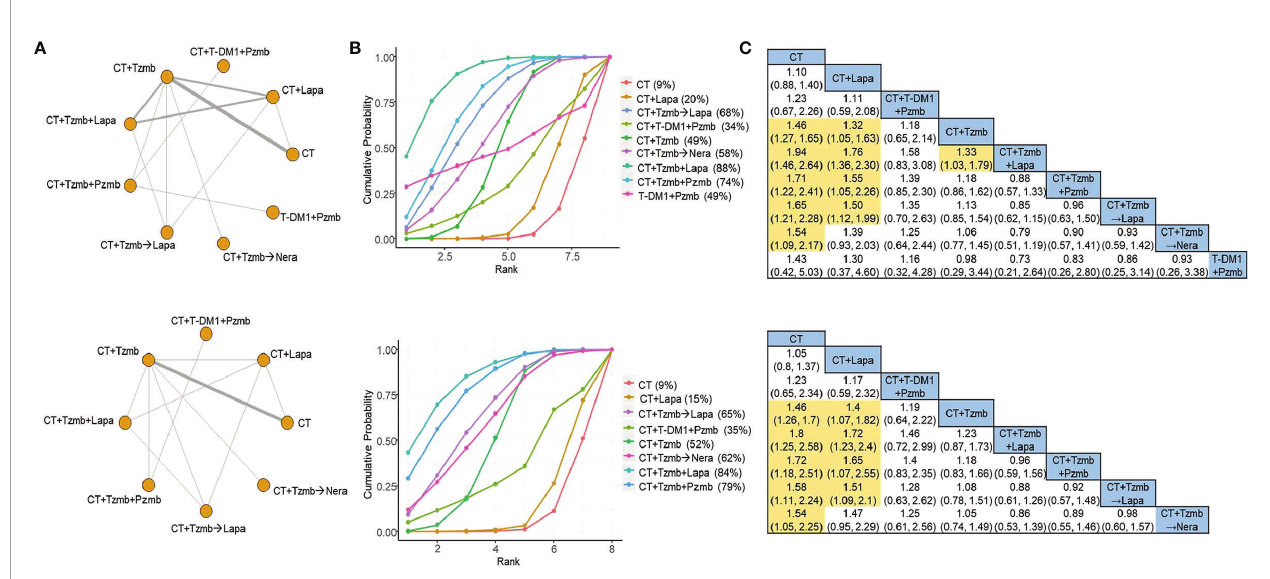
FIGURE 3 | Network meta-analysis for overall survival. (A) Network plots for overall survival in the overall analysis (top panel) and in the parallel analysis (bottom panel). (B) Ranking probabilities of surface under the cumulative ranking curve for overall survival in the overall analysis (top panel) and in the parallel analysis (bottom panel). (C) Cross-comparison odds ratios and their corresponding 95% con fi dence intervals for overall survival in the overall analysis (top panel) and in the parallel analysis (bottom panel). CT, chemotherapy; Lapa, lapatinib; Nera, neratinib; Pzmb, pertuzumab; T-DM1, trastuzumab emtansine; Tzmb,